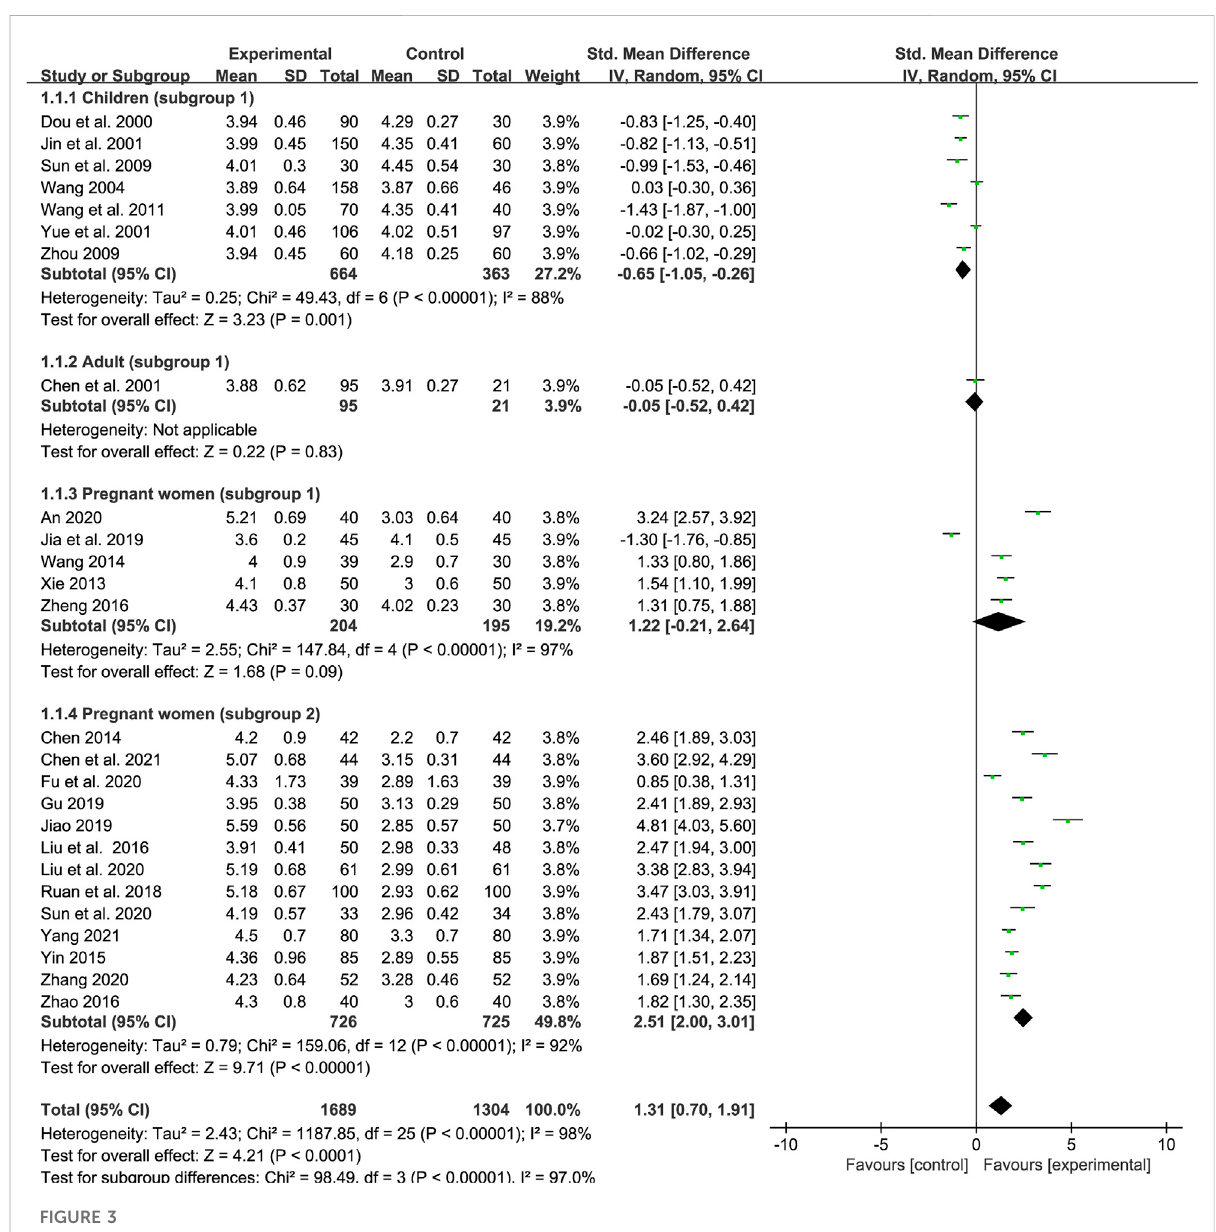
FIGURE 3 The forest plot assessing the effect of SXN on RBC